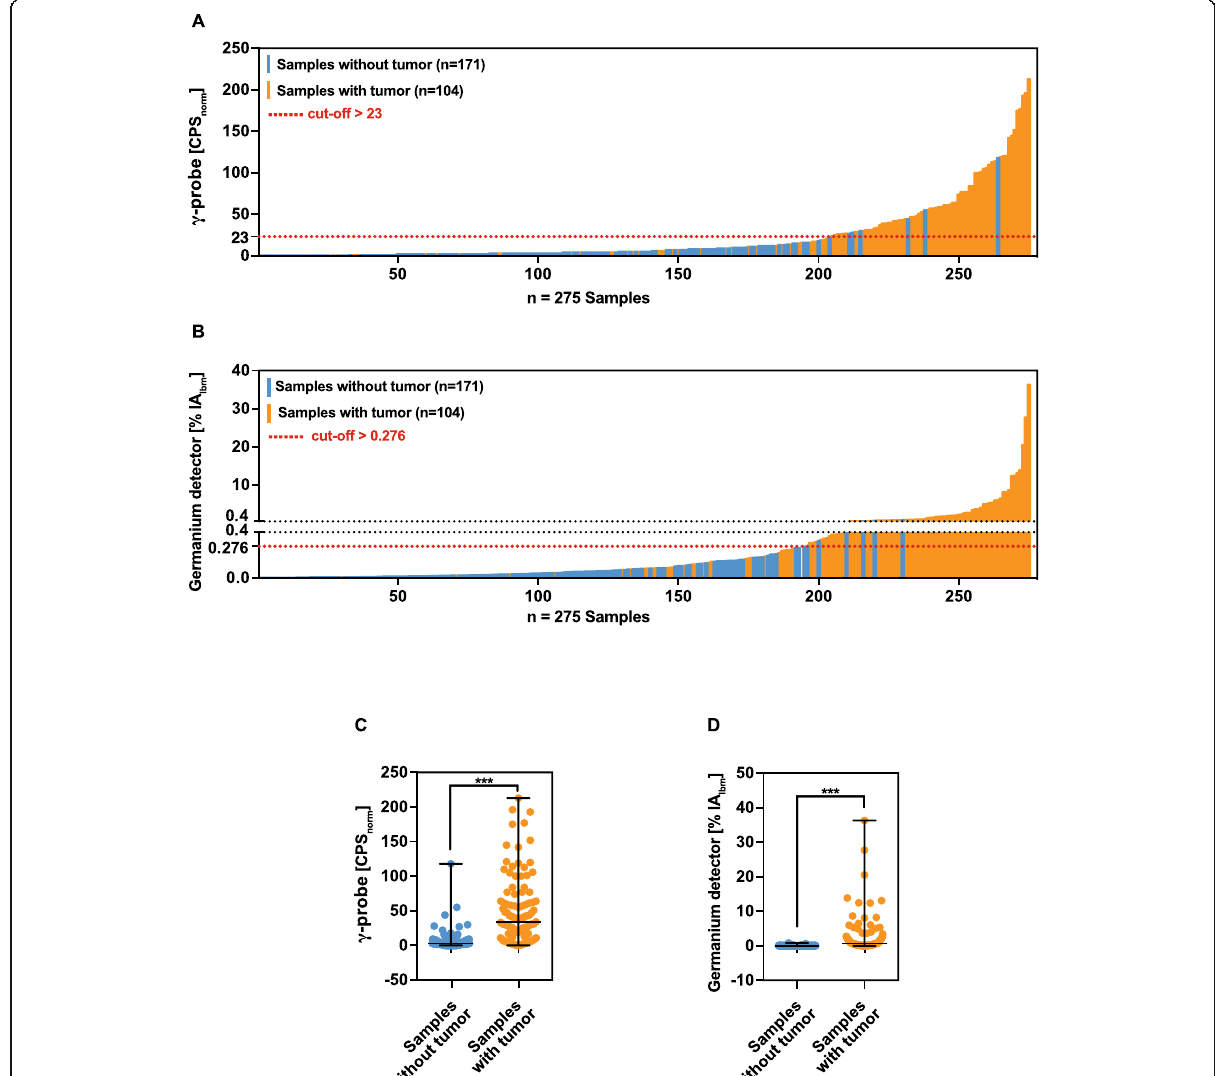
Fig. 4 a Waterfall plot of the CPS norm [CPS/(MBq/kg)] and b tracer uptake [%IA Ibm ] of tumour-free samples and tumour-containing samples illustrating the power of discrimination of [ 111 In]PSMA-617. CPS norm ( c ) and %IA Ibm ( d ) from samples with and without tumour is shown in scatter plots; horizontal black lines represent the medians ± range. *** p ≤